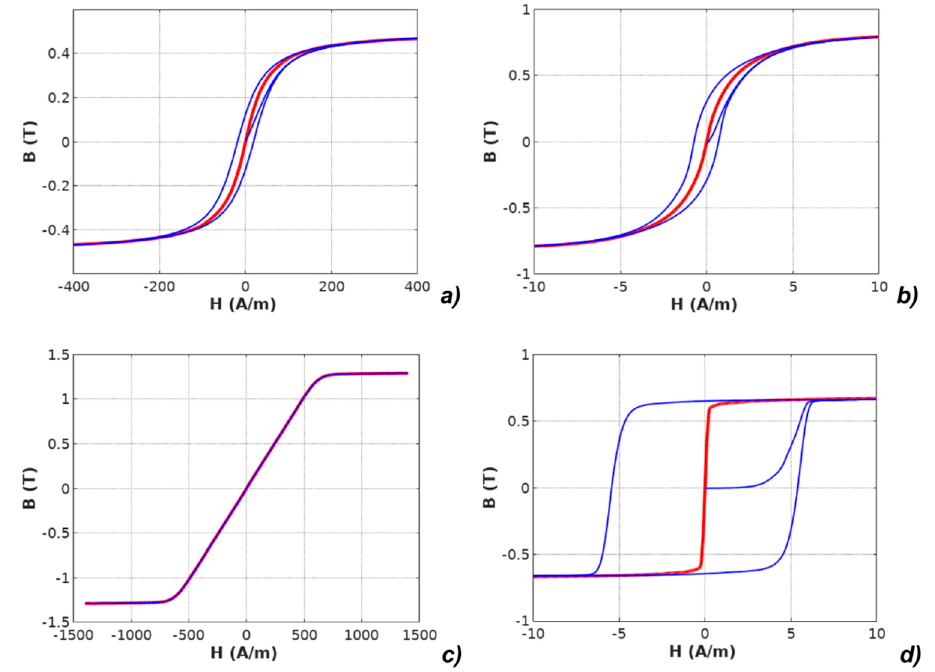
Figure 2. Results of measurements of hysteresis loops and anhysteretic magnetization curves (anhysteretic magnetization curve: red line, magnetic hysteresis loop: blue line): ( a ) Mn-Zn ferrite F3001, ( b ) Co 67 Fe 4 Mo 1 B 11 Si 17 amorphous alloy, ( c ) Fe 73.5 Cu 1 Nb 3 Si 15.5 B 7 nanocrystalline alloy with perpendicular anisotropy, ( d ) Fe 67 Co 18 B 14 Si 1 amorphous alloy with parallel anisotropy.